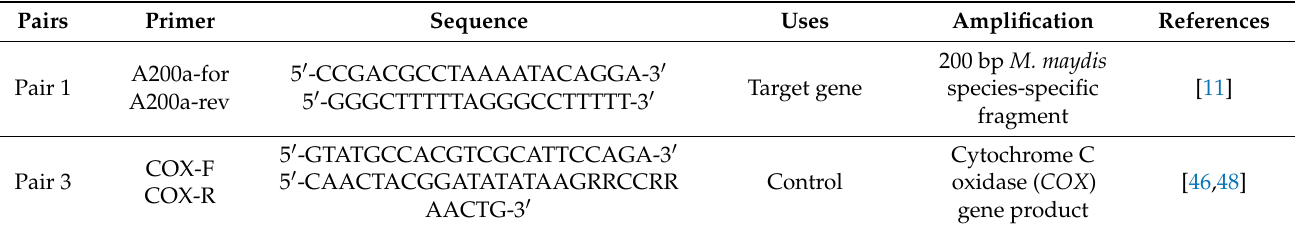
Table 2. Primers for Magnaporthiopsis maydis